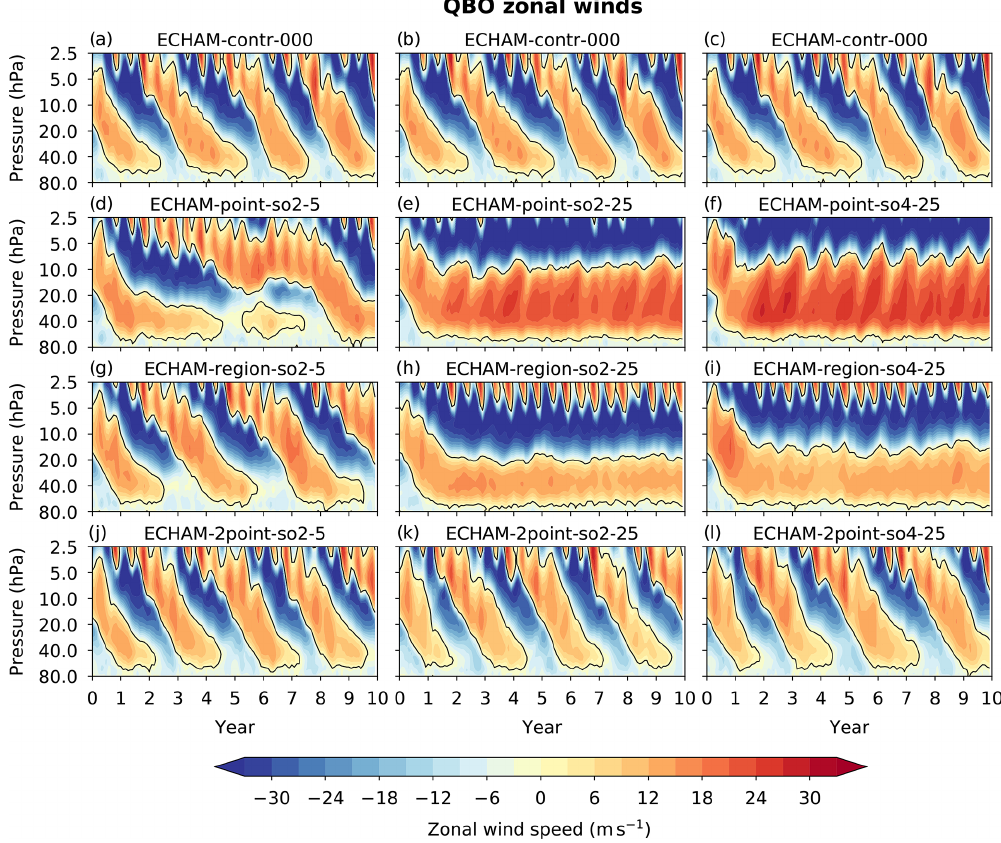
Figure 1. Time–height cross sections of the 5 ◦ N to 5 ◦ S mean zonal wind in the stratosphere over the simulation period of 10 years for ECHAM for different injection scenarios. The columns indicate the injection species and rate: the left column shows SO 2 injections with an injection rate of 5Tg ( S ) yr − 1 , the middle column shows SO 2 injections with an injection rate of 25Tg ( S ) yr − 1 , and the right column shows AM − SO 4 injections with an injection rate of 25Tg ( S ) yr − 1 . The rows indicate the injection strategy: the first row shows the control simulation, the second row shows the point injection, the third row shows the region injections, and the fourth row shows the 2point injection. The solid black line marks a tropical mean zonal wind speed of 0ms − 1